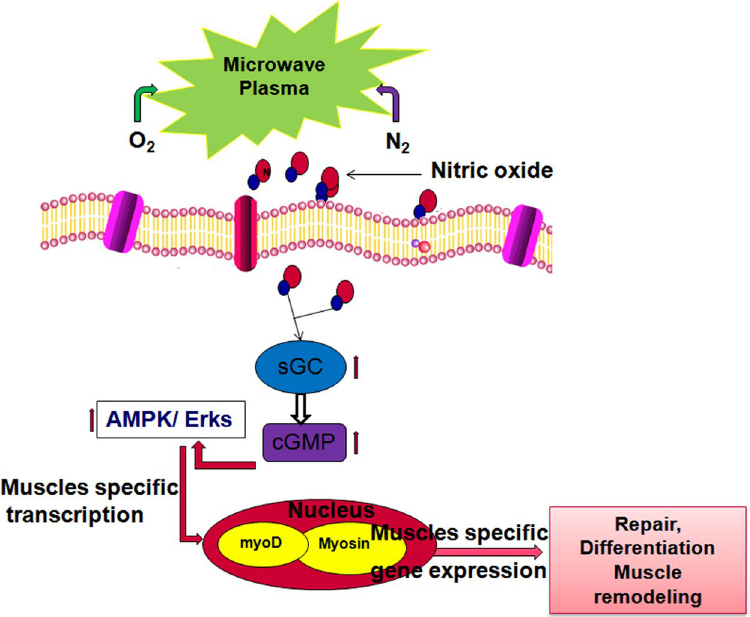
Figure 7. Nitric Oxide generated through microwave plasma penetrates inside the cell through the cell membrane that activates the myogenic specific gene as well as protein via a oxidative related signaling pathway, which leads to cell proliferation and differentiation in L6 skeletal muscle